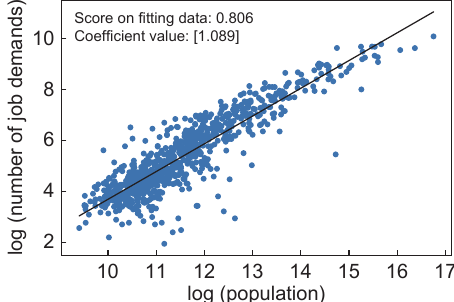
Fig. 9 log-log plot of the cosine distances between the vectors for MSAs and the center of mass for